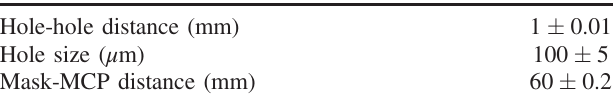
TABLE III. Parameters and dimensions of the pepper-pot emittance